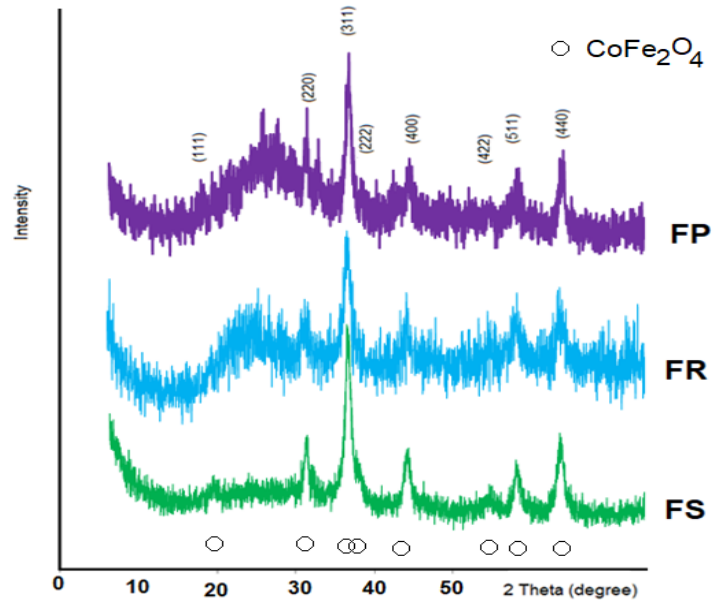
Figure 1. X-ray pattern of samples of composite materials (designated as cobalt (II) ferrite/Sunflower (FS), cobalt (II) ferrite/Rice (FR), and cobalt (II) ferrite/Peas (FP)).